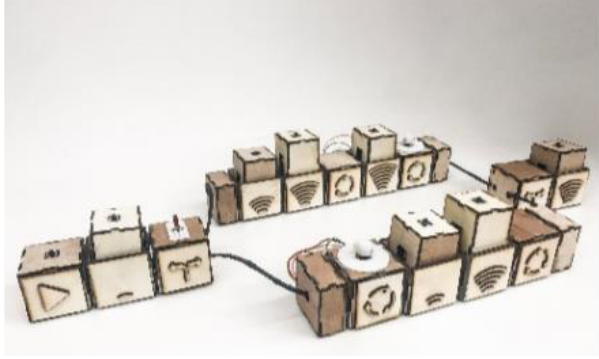
Figure 25. CodeRythm blocks